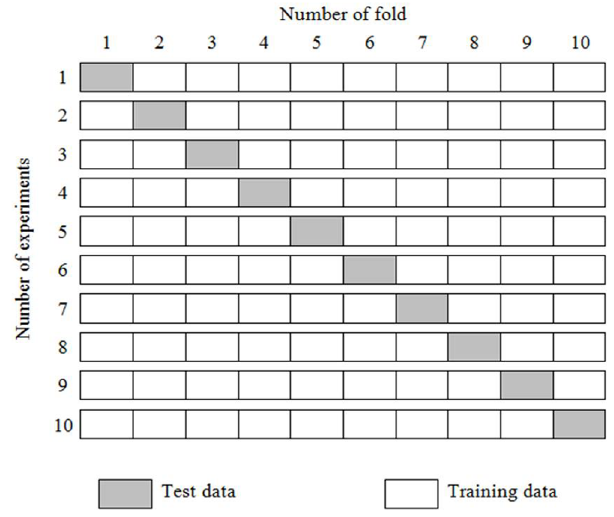
Figure 2. Cross-validation procedure with 10